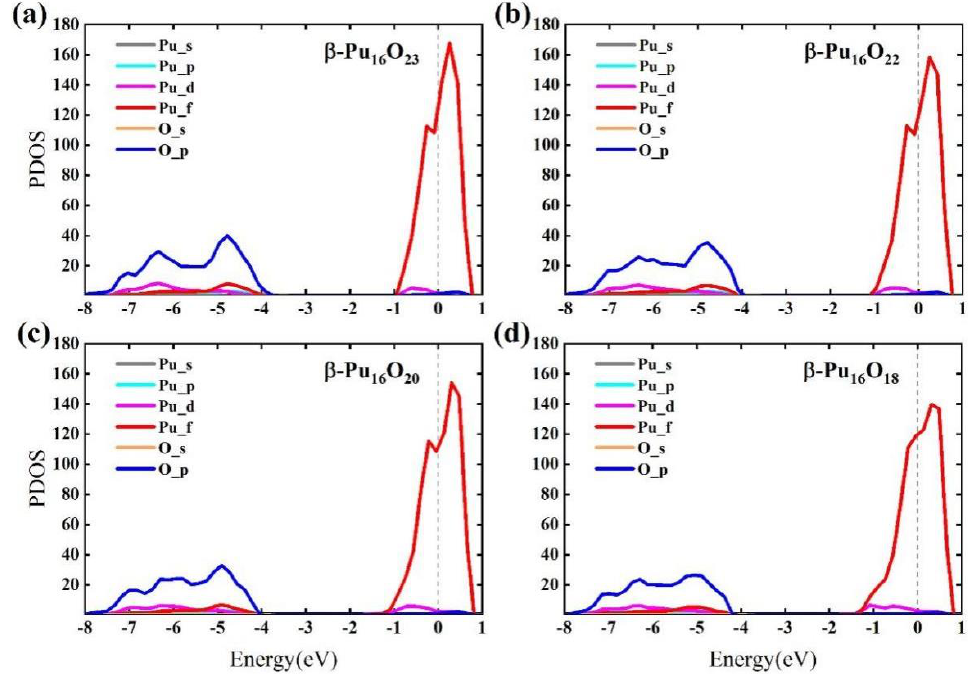
Figure 5. The electronic Pre-Departure Orientation Seminar (PDOS) of ( a ) β -Pu 16 O 23 , ( b ) β -Pu 16 O 22 , ( c ) β -Pu 16 O 20 , ( d ) β -Pu 16 O 18 . Table 4. Values of the Debye temperature and lattice thermal conductivity of the studied